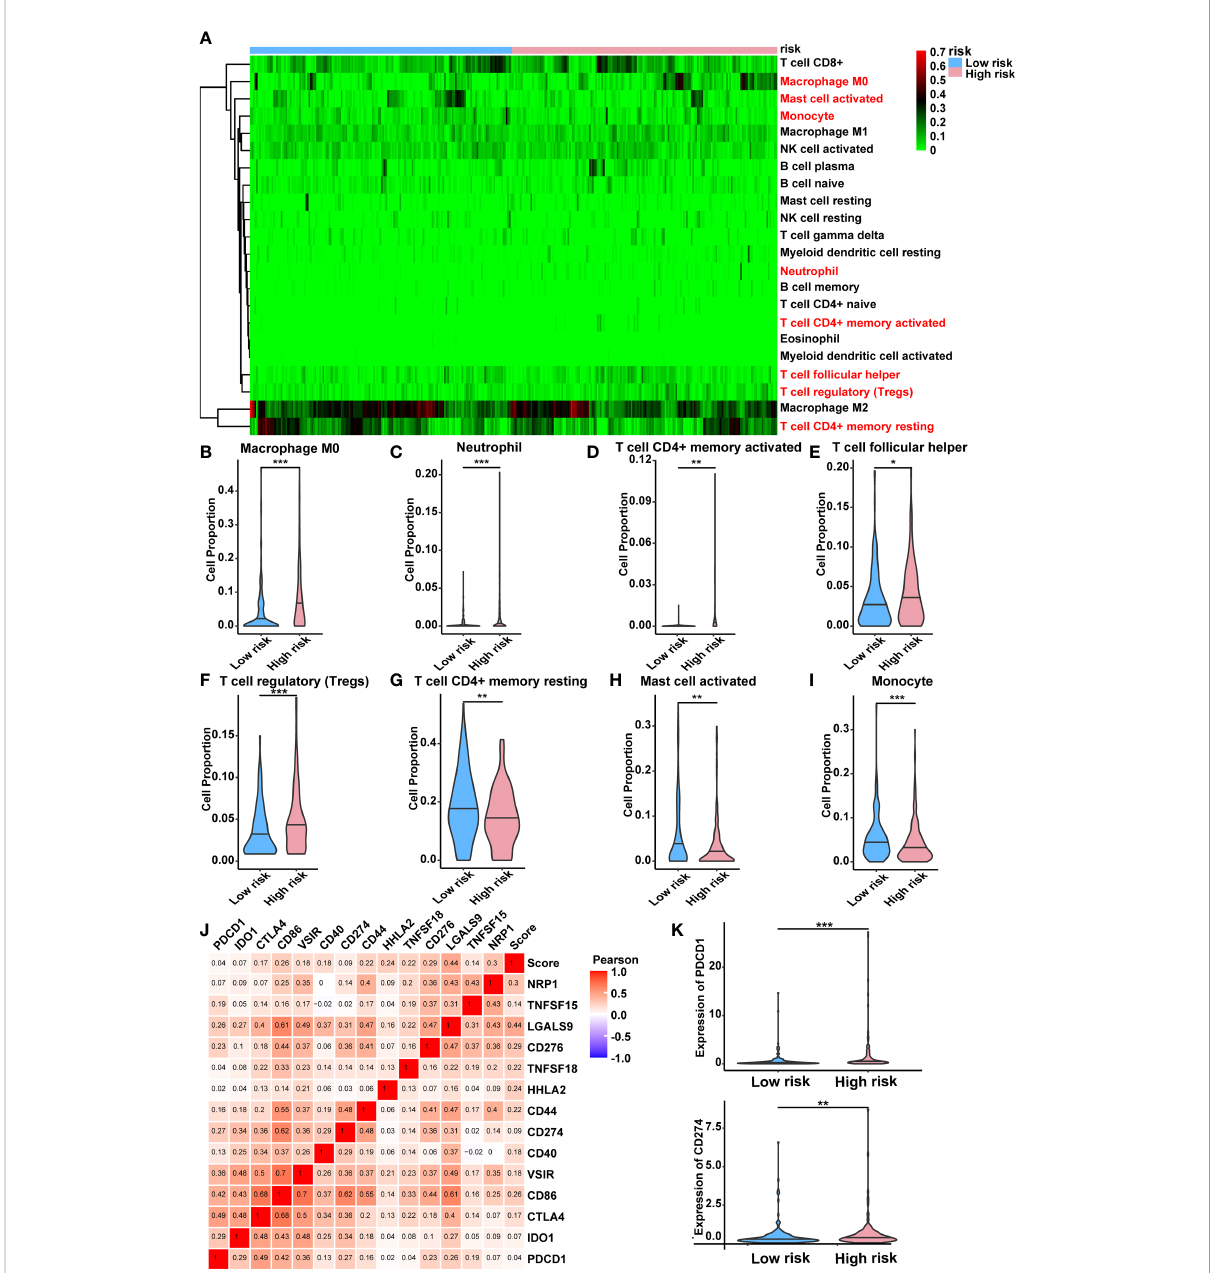
FIGURE 8 Relationship between the lncRNA-based signature and immune responses in HCC. (A) Relative proportion of 22 different immune cells based on CIBERSORT in the low-risk group and the high-risk group. Immune cells in red indicated that there was a signi fi cant difference within the two groups. (B-I) The proportion of M0 macrophages, neutrophil, activated memory CD4+ T cells, follicular helper T cells, regulatory T cells, activated mast cell, monocyte and resting memory CD4+ T cells in the low-risk group and the high-risk group. (J) Heat map showing the relations between risk score and various immune checkpoints via Pearson test. (K) PDCD1 and CD274 were signi fi cantly upregulated in the high-risk group. lncRNAs, long noncoding RNAs; HCC, hepatocellular carcinoma. *p < 0.05, **p < 0.01, and ***p <